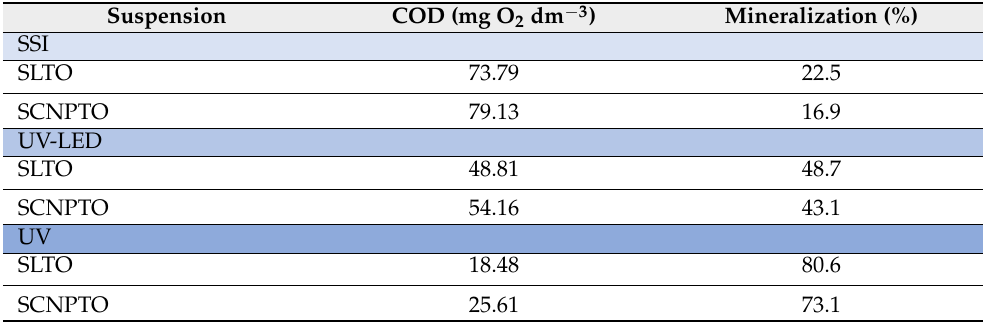
Table 1. Mineralization of the investigated solutions for different processes of degradation.